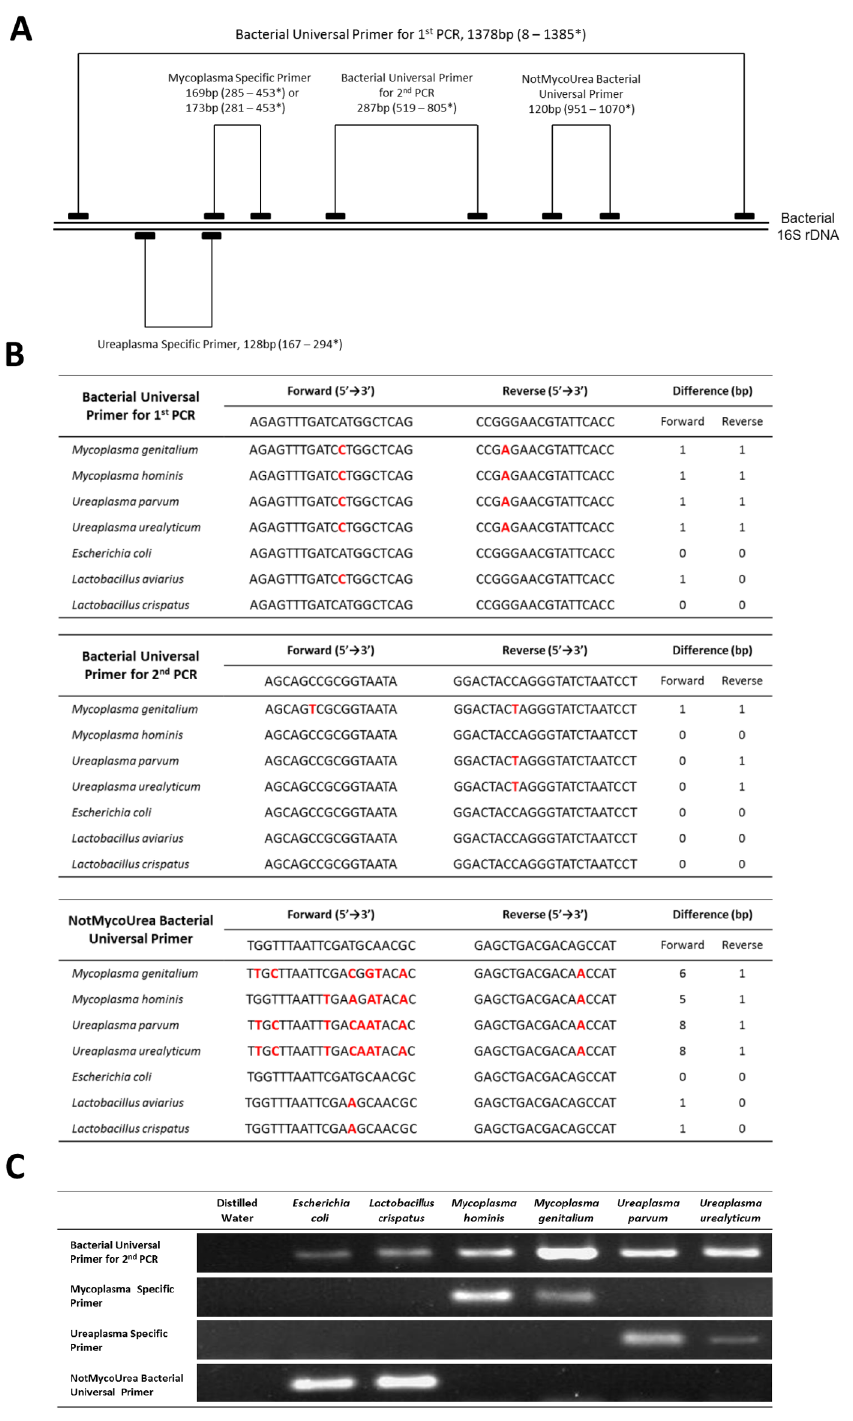
Fig 2. The strategy used for the primer design. ( A ) In an attempt to detect Mycoplasma , Ureaplasma and other bacteria, nested PCR was performed using the primer for the first PCR (Bacterial Universal Primer for 1 st PCR) at the start. For the second (nested) PCR, four kinds of primers (Bacterial Universal Primer for 2 nd PCR, Mycoplasma Specific Primer, Ureaplasma Specific Primer, and NotMycoUrea Bacterial Universal Primer) were used. * The amplicon sizes are described, and the amplified positons on Escherichia coli 16S ribosomal RNA (Accession No. J01859) are shown. Mycoplasma and Ureaplasma Specific Primers do not bind to E . coli 16S rDNA. ( B ) The sequence homology between the primers (Bacterial Universal Primer for 1